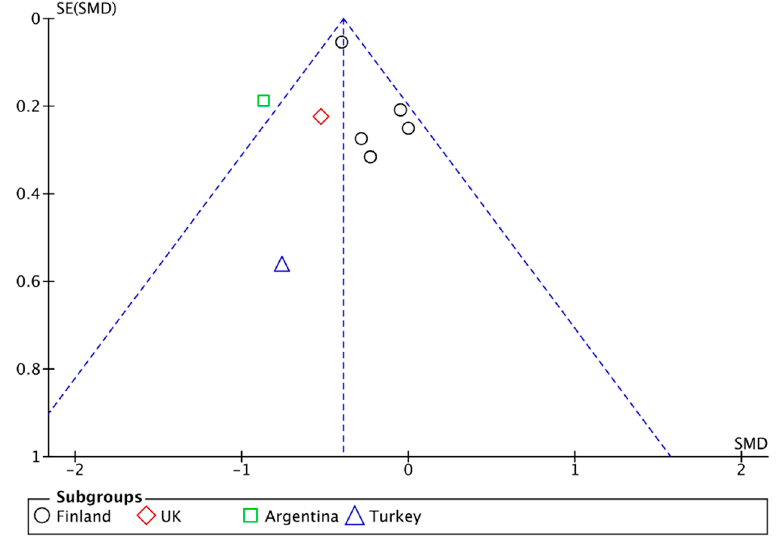
Figure 8. Funnel Figure 8. Funnel plot.